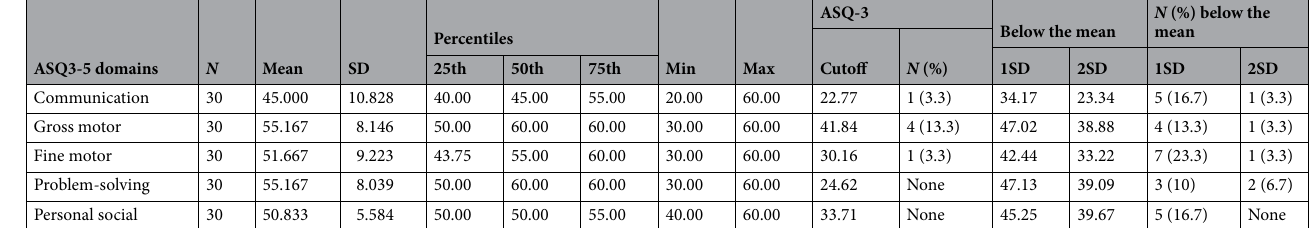
(Table S10). Further, multiple regression analyses were performed only for urinary phthalate metabolites that exhibited negative association with ASQ-3 fine motor scores after adjusting separately for neonatal comorbidities such as respiratory distress syndrome, intraventricular hemorrhage, prolonged rupture of membrane and retinopathy of